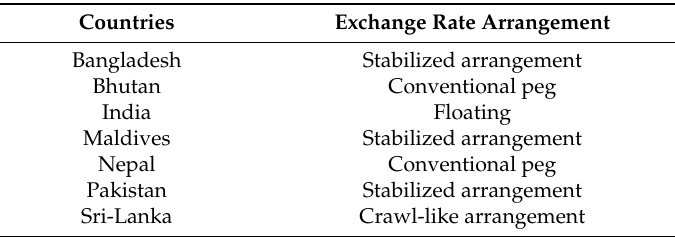
Table 2. Exchange Rate